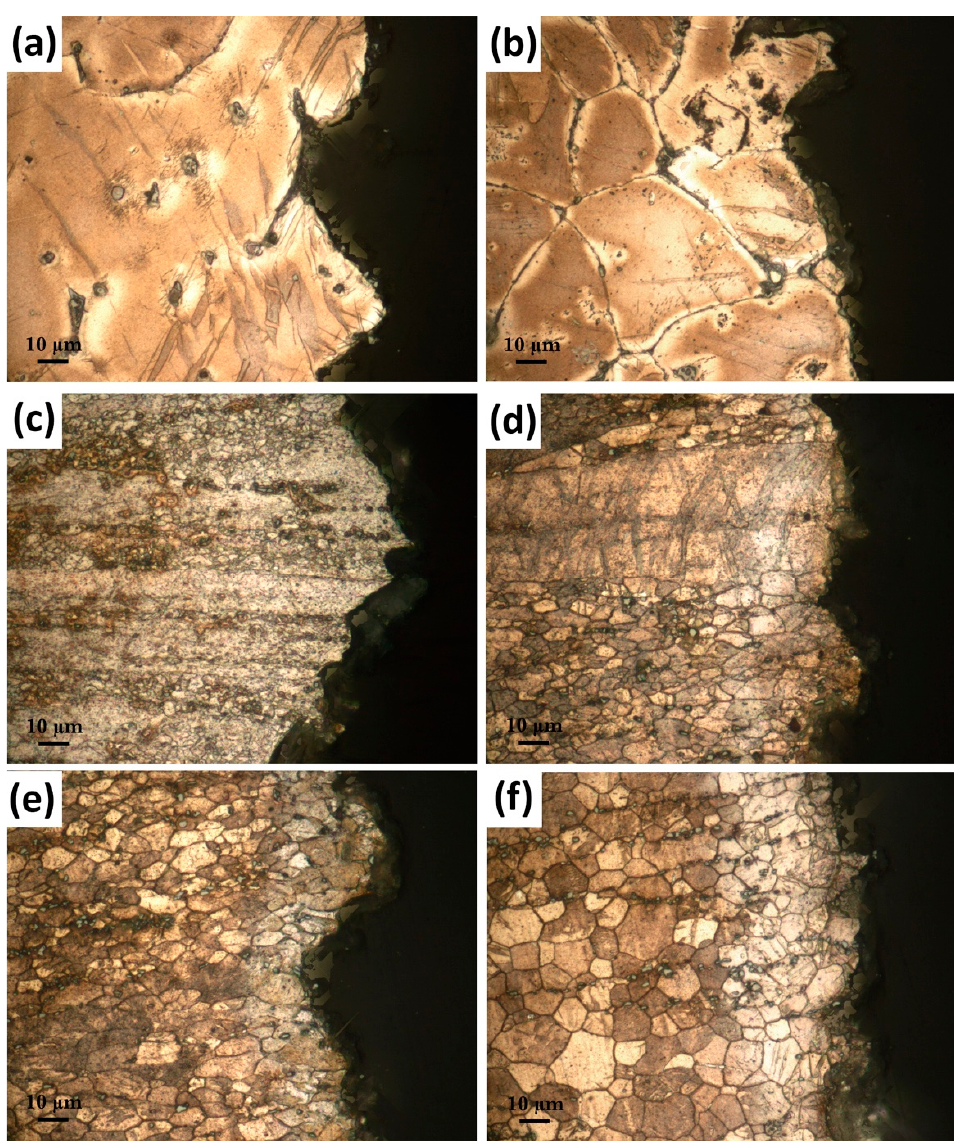
Figure 9. Cross-section optical micrographs of the fractured samples: ( a ) as-cast, ( b ) homogenized, extruded at ( c ) 250 °C, ( d ) 300 °C, ( e ) 350 °C, and ( f ) 400 °C.